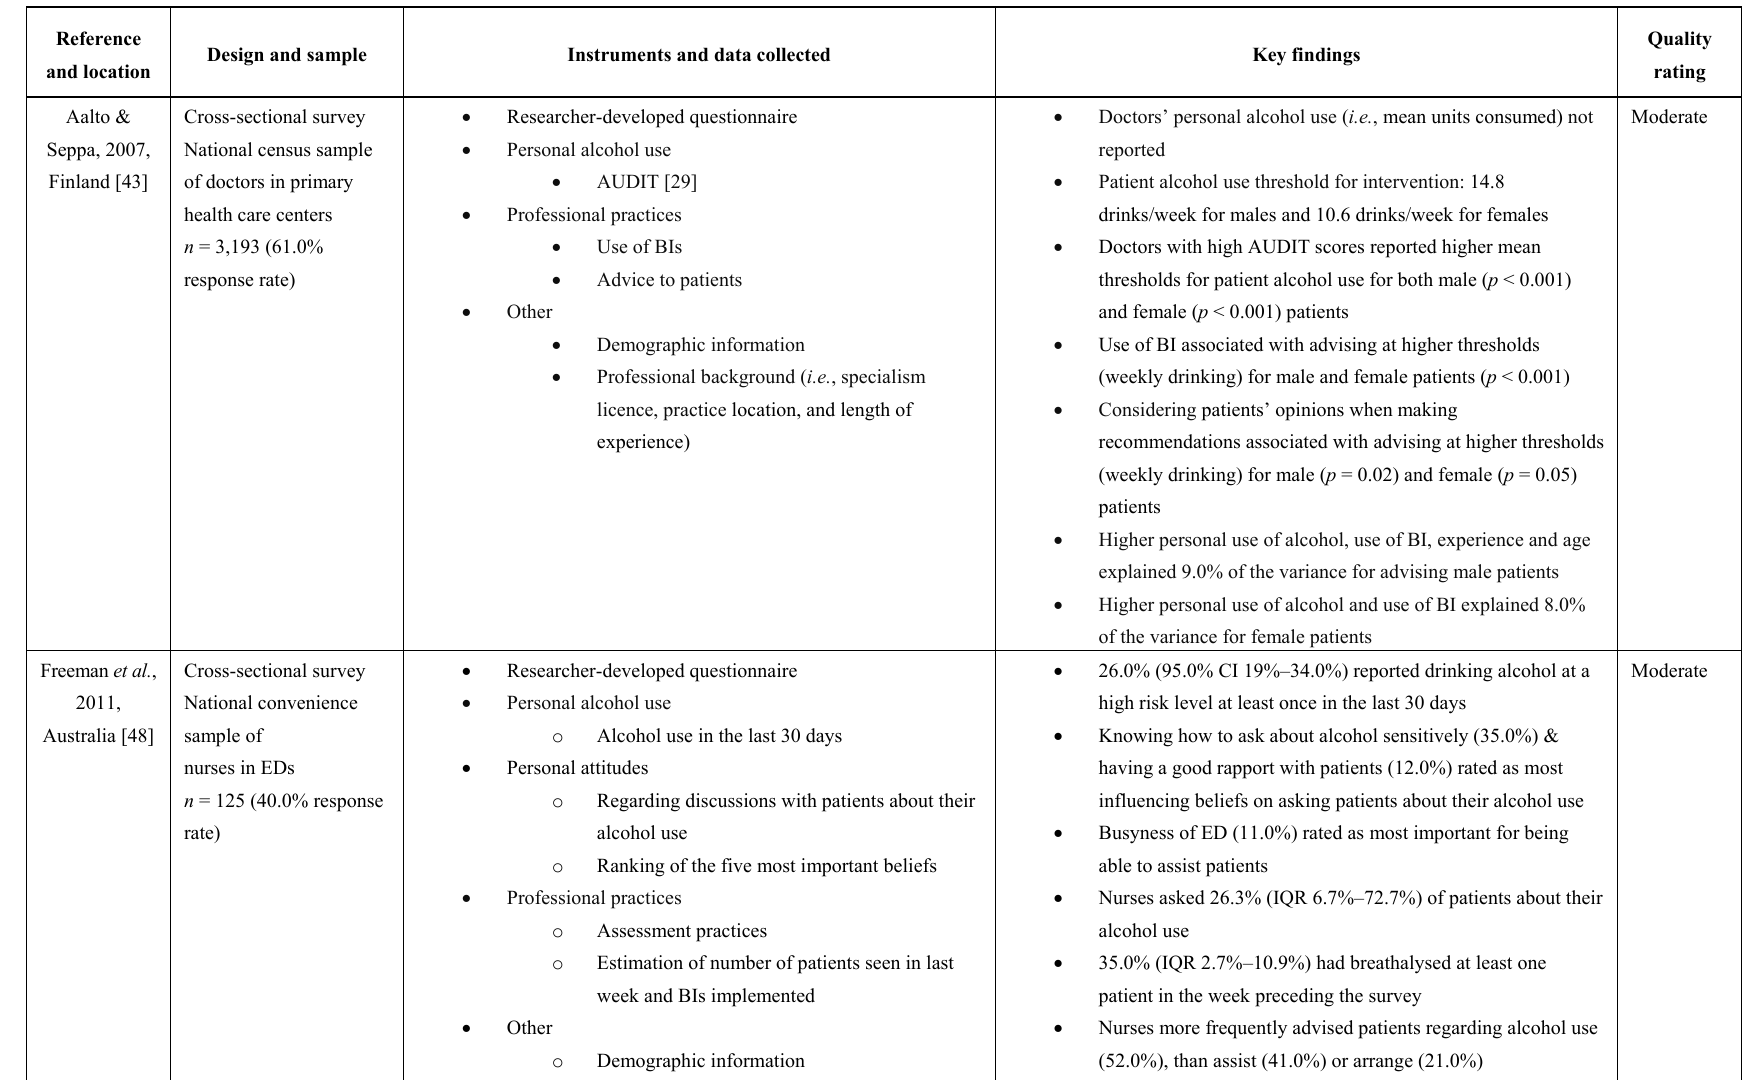
Table 6. Studies included in the